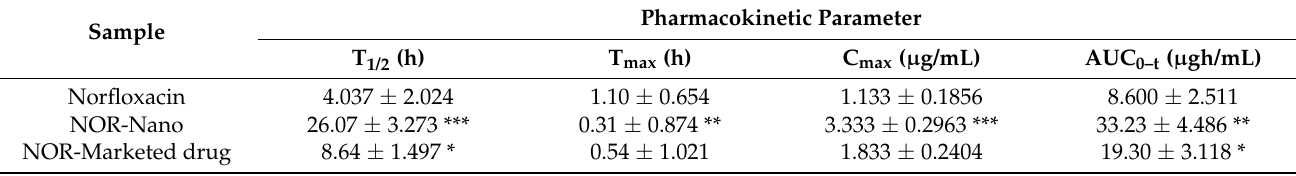
Figure 10. Pharmacokinetic profile of Norfloxacin (NOR), Norfloxacin nanoparticles (NOR-Nano) and Norfloxacin marketed drug (NOR-Marketed drug). Plot of plasma concentration ( µ g/mL) vs. time (h). Data presented as mean ± SEM. * p < 0.05, *** p < 0.001 as compared to Norfloxacin treated rats at respective time-period. Two-way repeated measures ANOVA followed by post hoc Bonferroni’s analysis. Table 6. Pharmacokinetic parameters for Norfloxacin (NOR), its nanoparticles (NOR-Nano), nano-dosage form (NOR-Nano dosage form) and marketed drug (NOR-Marketed